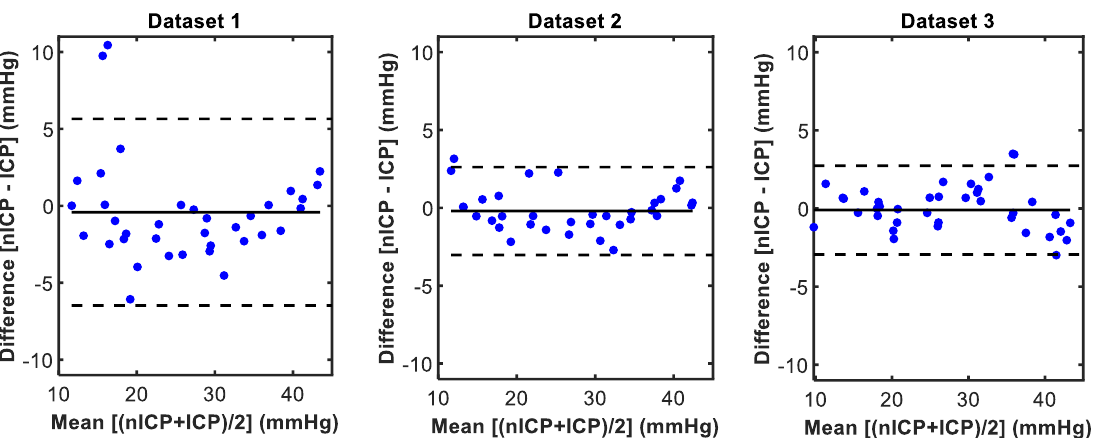
Figure 7. Bland and Altman plots between predicted non-invasive intracranial pressure (nICP) and the reference invasive ICP measurements.